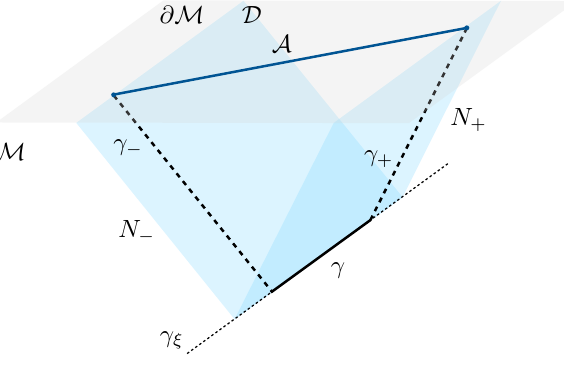
Figure 1 . In three dimensions the swing surface homologous to the boundary interval